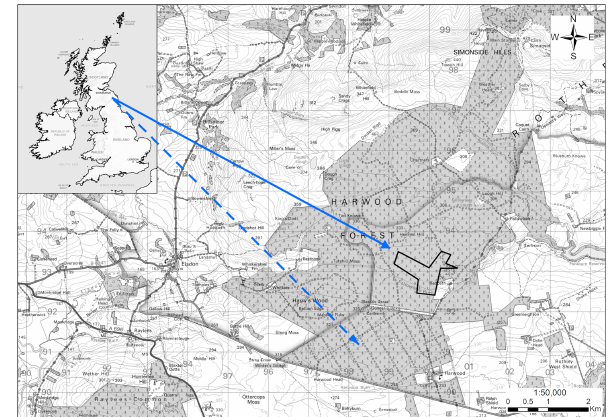
Figure 1. Map of experimental areas at Harwood Forest, Northum- berland, UK. The dotted arrow shows the unfelled mature spruce stand area (A) and the solid arrow shows the area that was clear- felled (outlined in black) after one year (B). Note: the map is ac- cording to © Crown copyright and database right 2021. Ordnance Survey Licence number